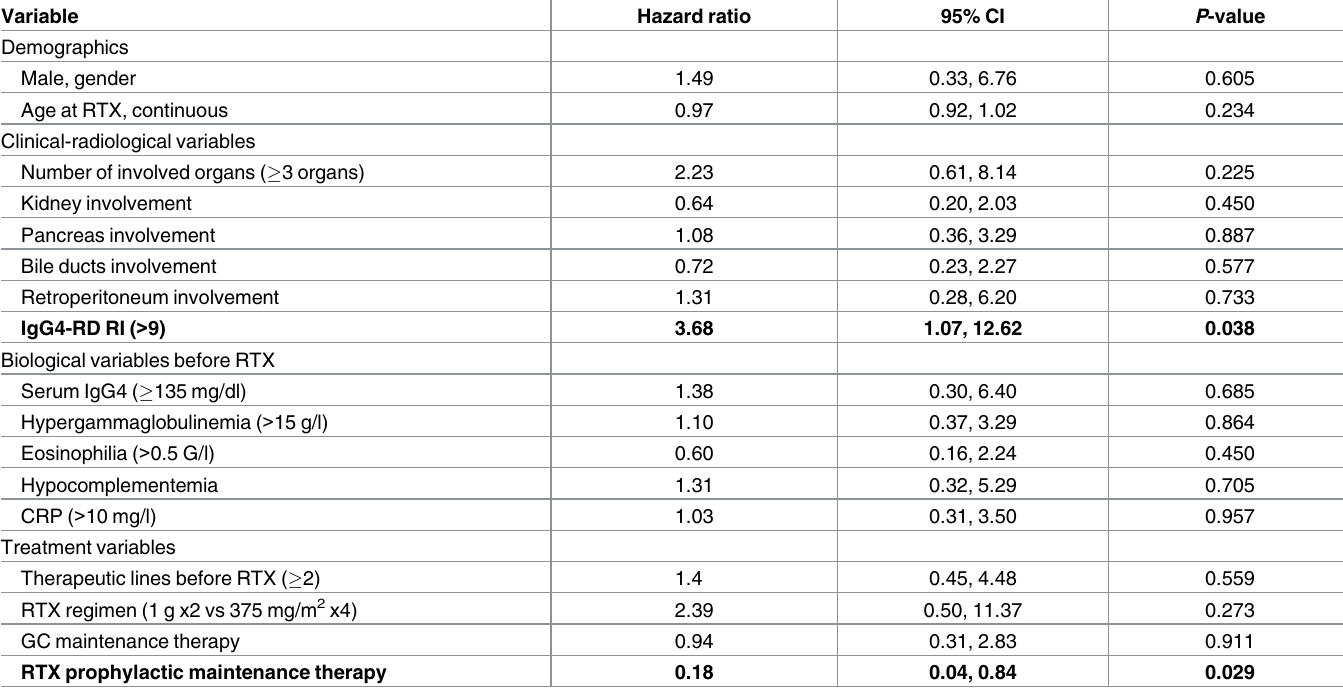
Table 4. Hazard ratio for risk of flare: Unadjusted Cox